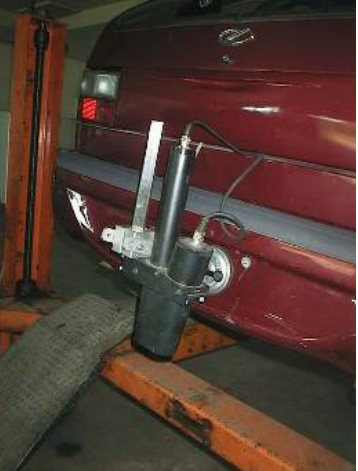
Figure 5. Correlation-optical sensor for measurement of vehicle longitudinal speed .